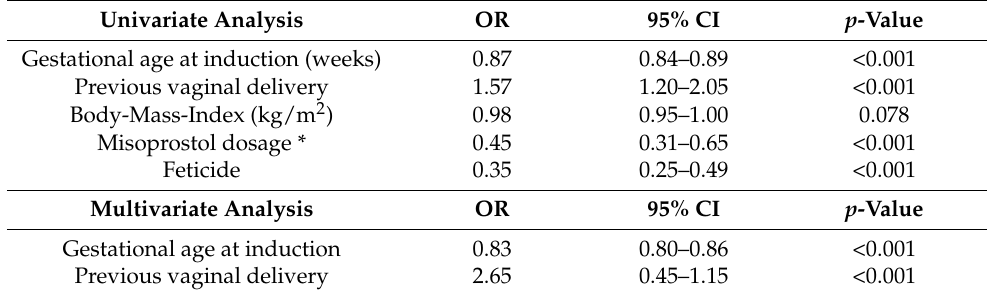
Table 3. Univariate and multivariate logistic regression analysis predicting an induction–expulsion interval of 12 h or